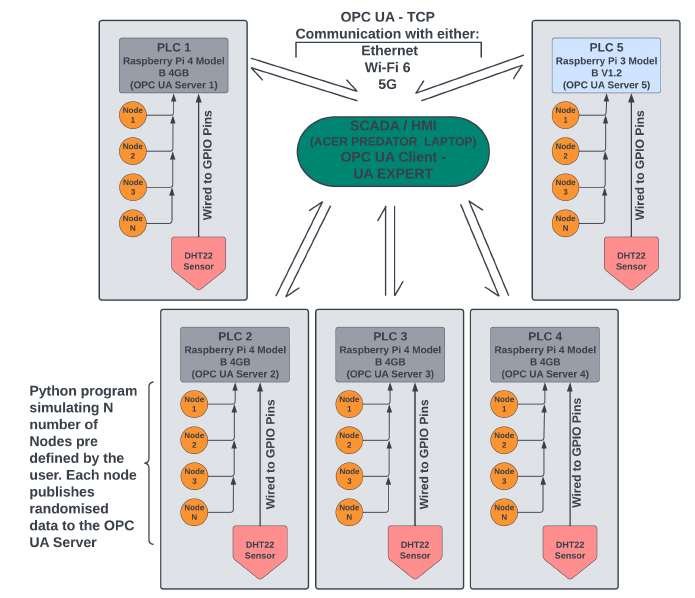
Figure 3. System Design Architecture.